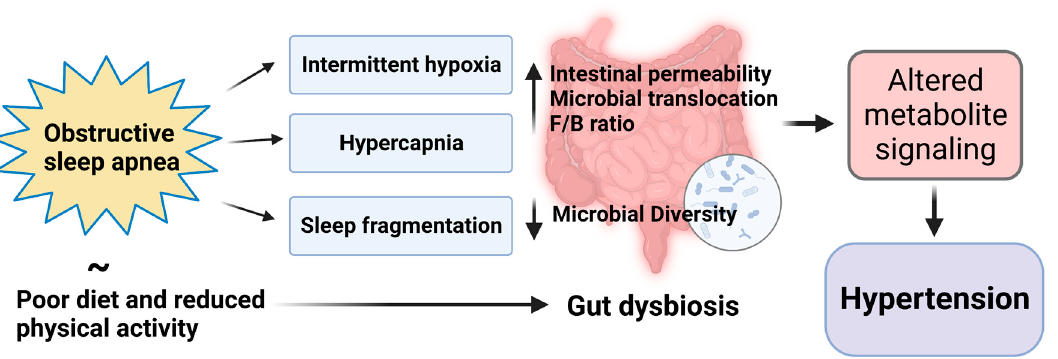
Figure 3. Schematic highlighting the interplay between obstructive sleep apnea and gut microbiome in altering metabolite signaling and facilitating the development of hypertension. F/B—Firmicutes- to-Bacteroidetes ratio. Created with BioRender.com.